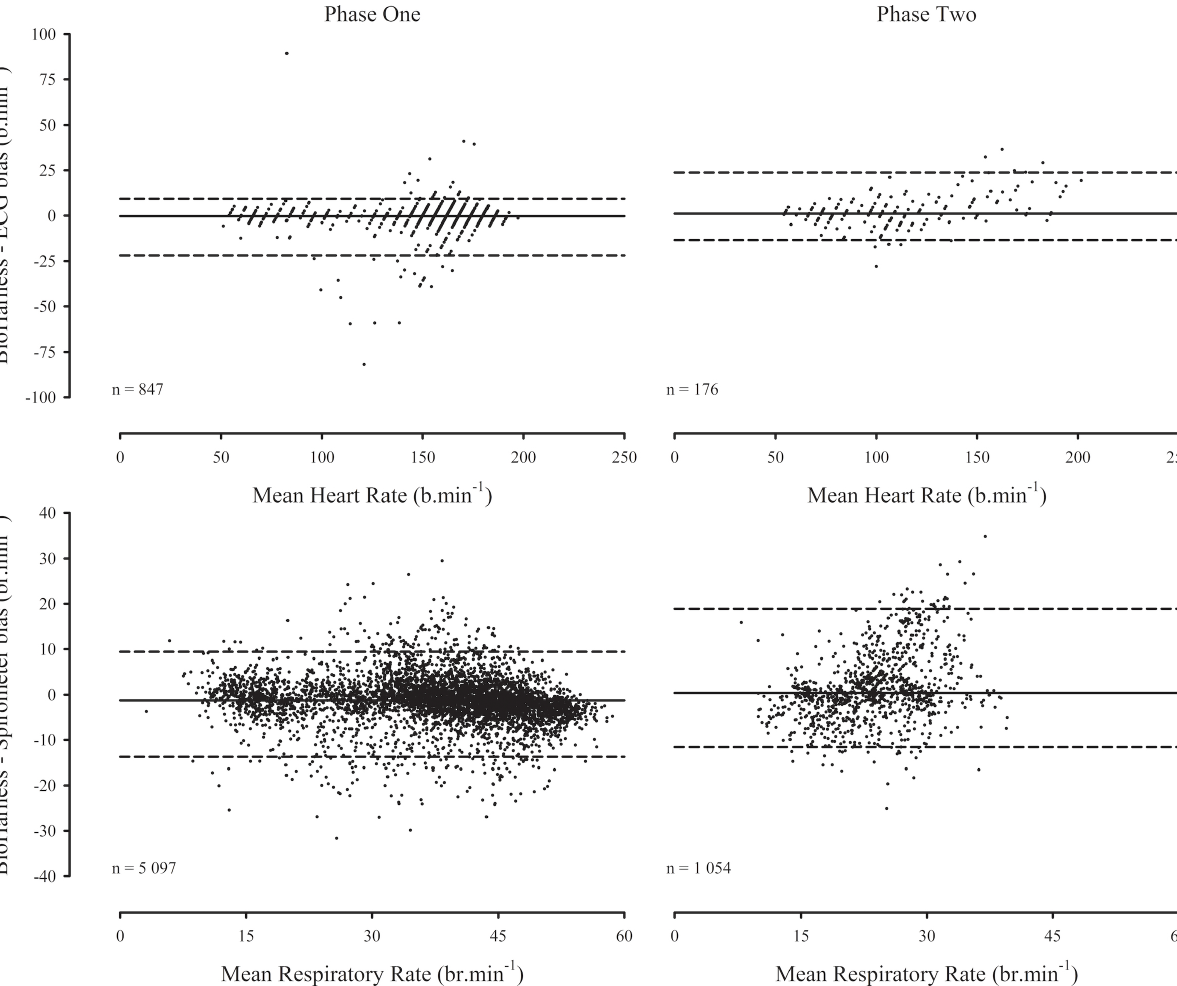
Figure 3. Sensor measurement error as a function of mean measurement magnitude (solid reference lines = mean biases, dashed reference lines = 95% limits of